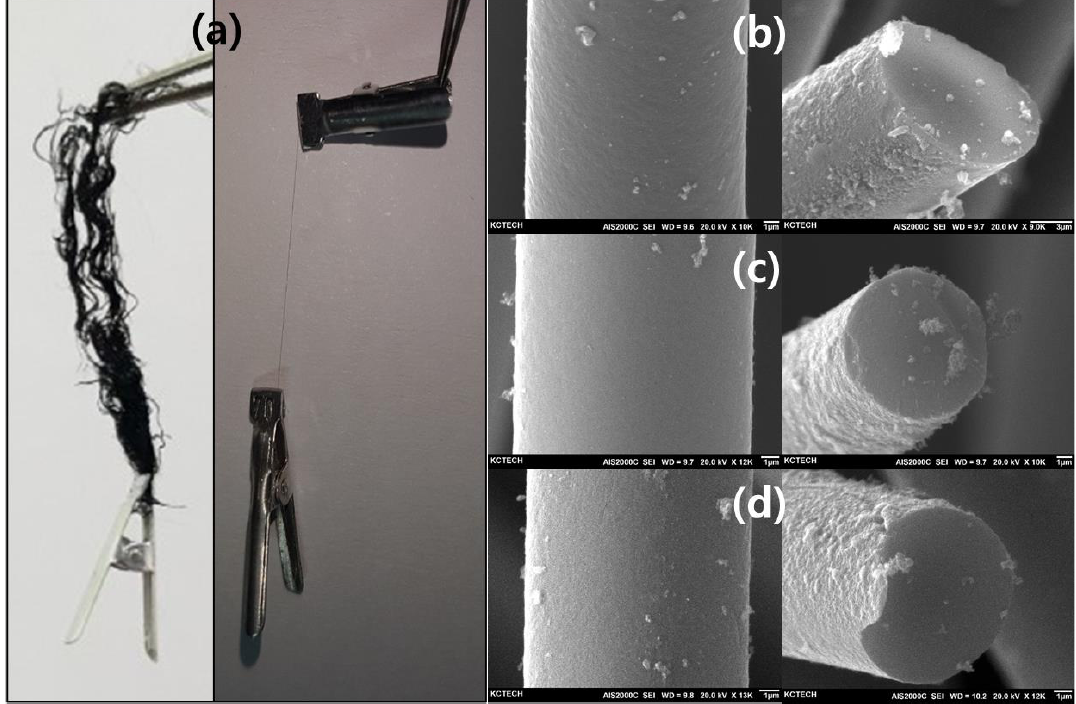
Figure 7. Optic and SEM images of activated carbon fibers: ( a , b ) ACF-9-2, ( c ) ACF-9-3, ( d )